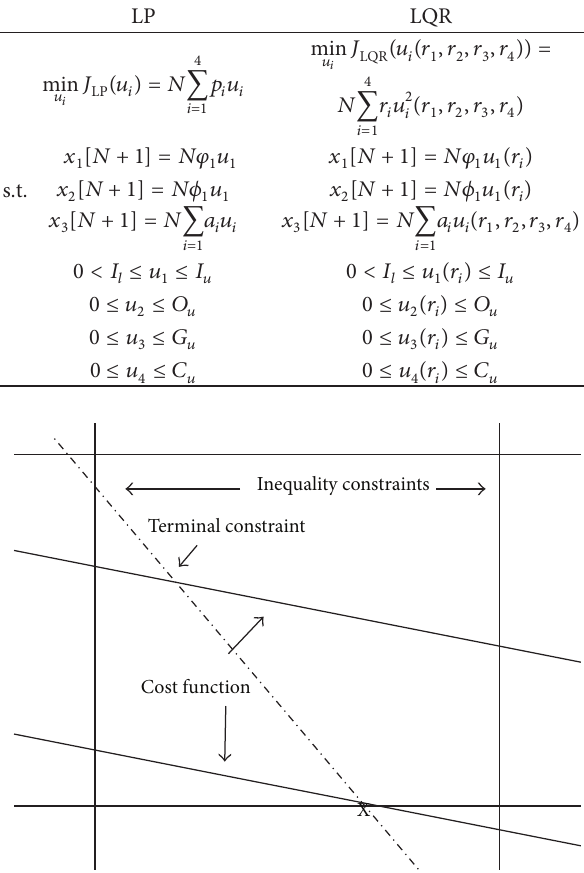
Figure 2: 𝑋 = solution of linear